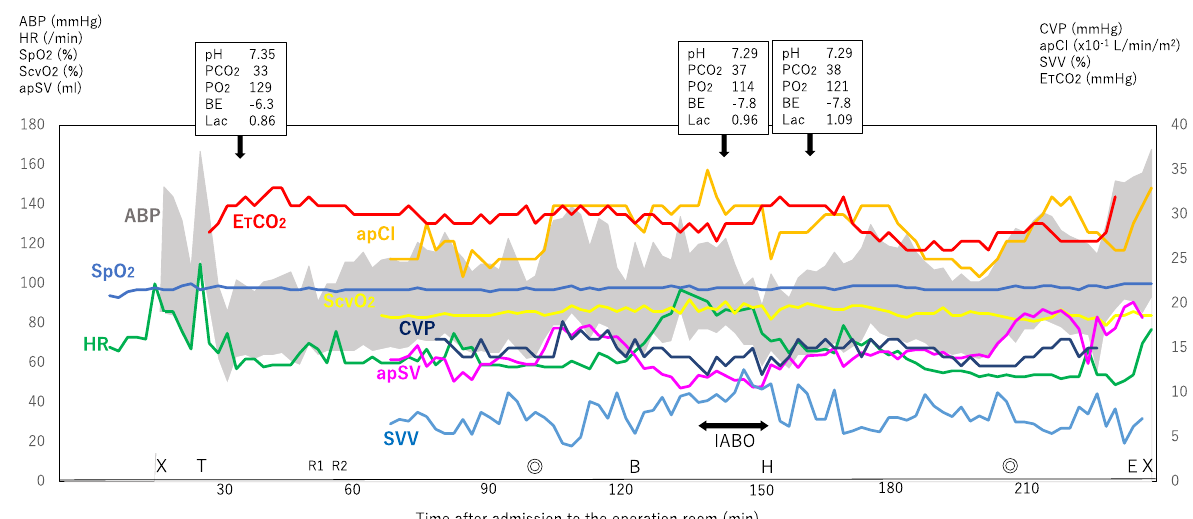
Fig. 2 Trends in hemodynamic parameters during anesthesia. Minute ventilation is constant during surgery. Further, FiO 2 is maintained at 0.67 throughout anesthesia, and abdominal pressure is not applied at delivery of the baby. Oxytocin is not administered after delivery. HR, heart rate, SpO 2 , percutaneous arterial oxygen saturation, ABP, arterial blood pressure, ETCO 2 , end-tidal carbon dioxide partial pressure, ScvO 2 , central venous oxygen saturation, apCI, arterial pressure-based cardiac index, CVP, central venous pressure, SVV, stroke volume variation, apSV, arterial pressure-based stroke volume. X, anesthesia start/finish, ◎ , operation start/finish, B, baby delivery, T, intubation, E, extubation, IABO, intra-aortic balloon occlusion, H, hysterectomy, R1, insertion of the IABO sheath, R2, insertion of the transesophageal echocardiography